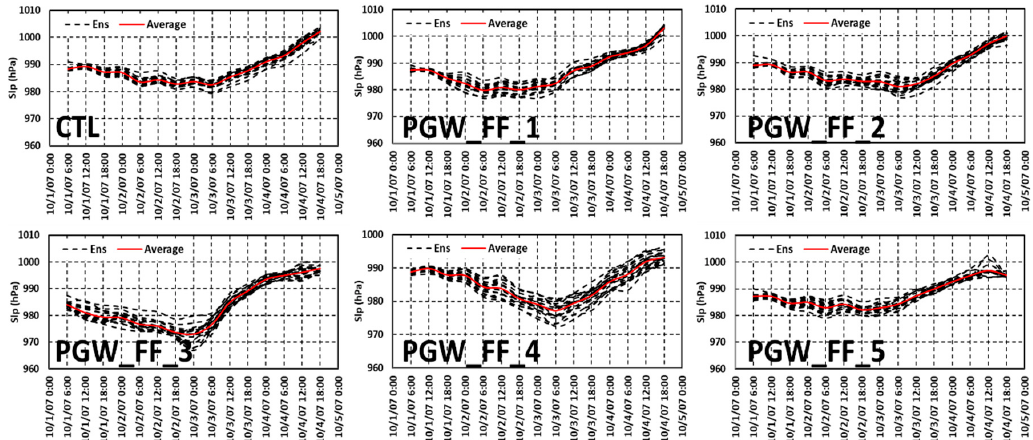
Figure 7. The predicted results from nineteen ensemble members of MSLP simulated by control (CTL) and PGW_FF experiments. Black dash lines and the red line are the results of each member and the average value of nineteen ensemble members, respectively.